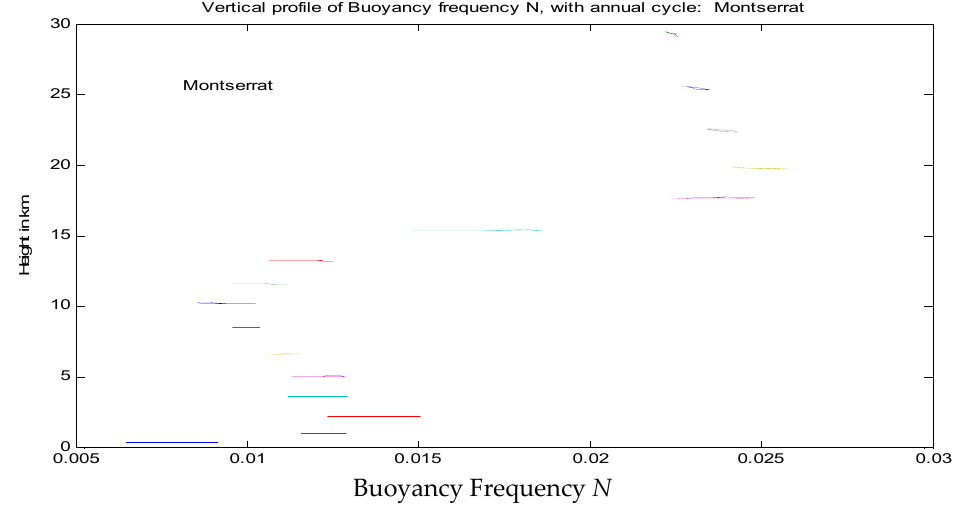
Figure 2. Vertical profile and annual cycle of the buoyancy frequency N in the vicinity of the Caribbean island of Montserrat. The individual coloured lines show the annual cycle of N -values at their respective levels. Other locations at mid-latitudes show similar behaviour—the dominant feature for present purposes is the large change in N across the tropopause, here taken at a height of 14 km, throughout the annual cycle.